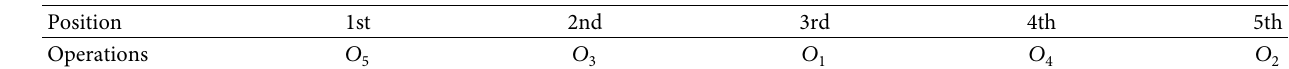
Figure 1: An MHSP example. Table 2: A permutation